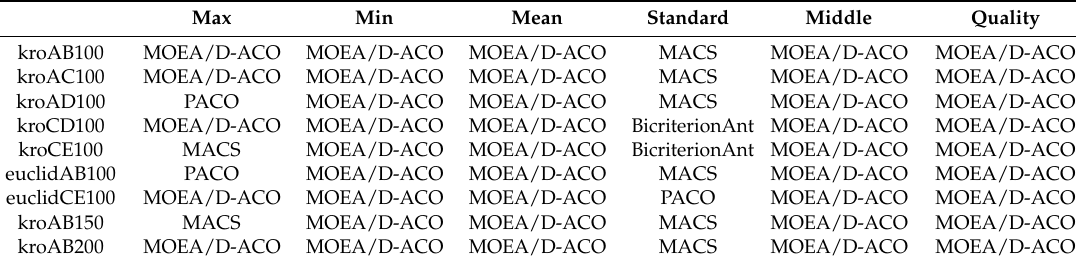
Table 2. Comparison of several